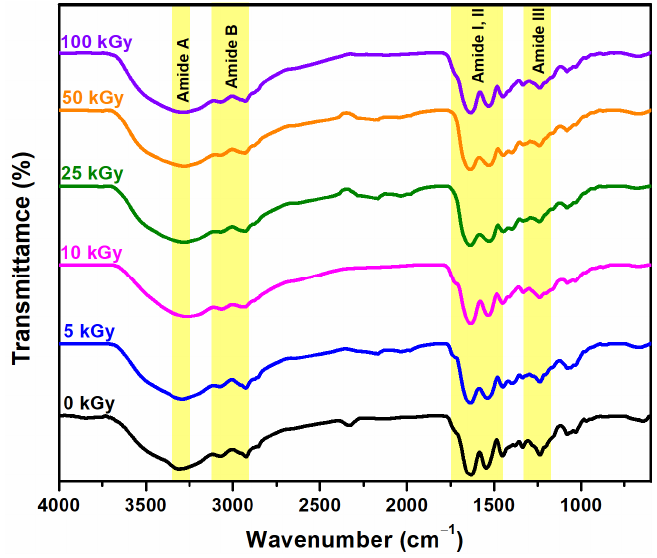
Figure 4. FTIR spectra for uncrosslinked and crosslinked dried collagen hydrogel.